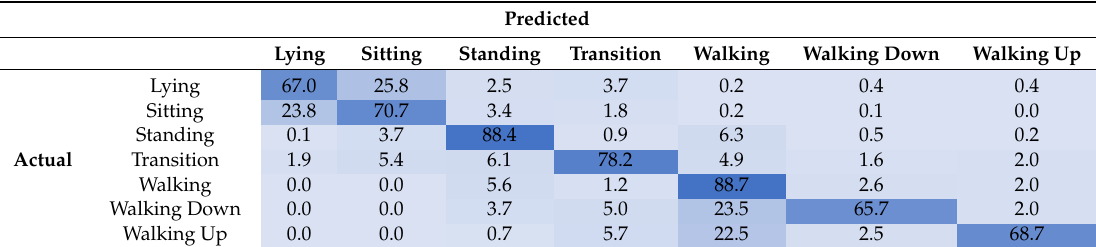
Table 3. Confusion matrix for the tuned multichannel CNN-LSTM (in percentage; darker blue indicates higher values).